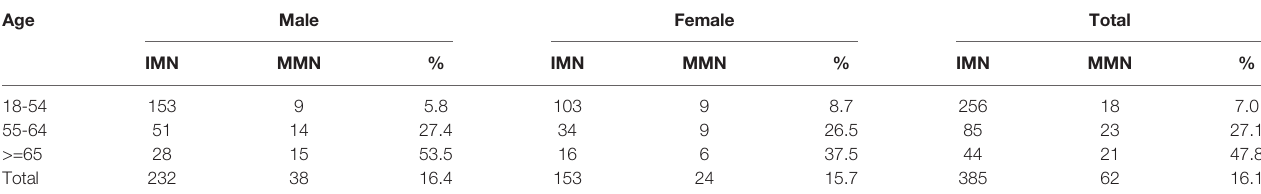
TABLE 3 | Age distribution of cancer cases in MN patients.